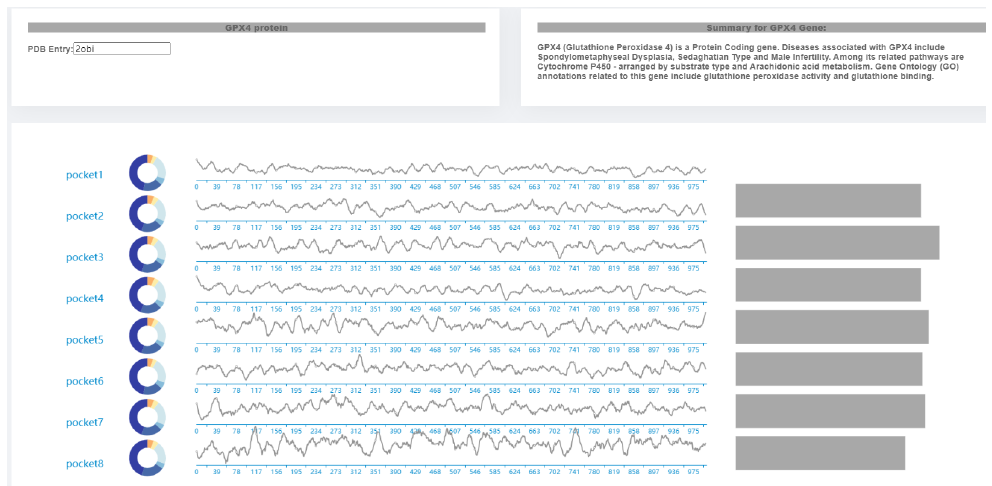
Figure 7. Molecular pocket feature navigation